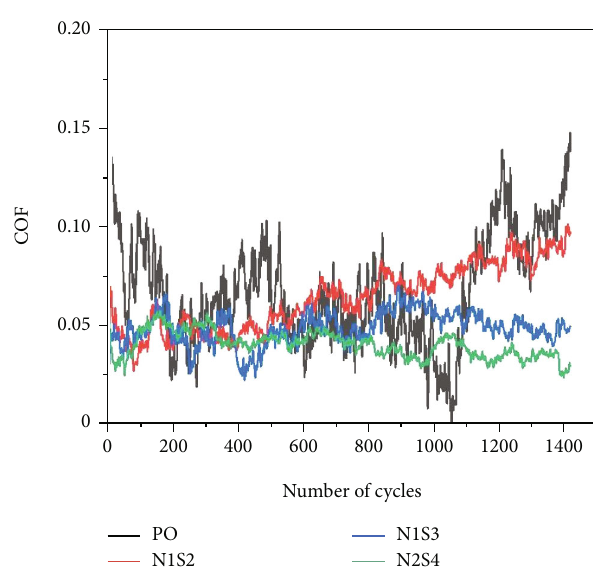
Figure 7: The friction coe ffi cient of PO and biolubricants.